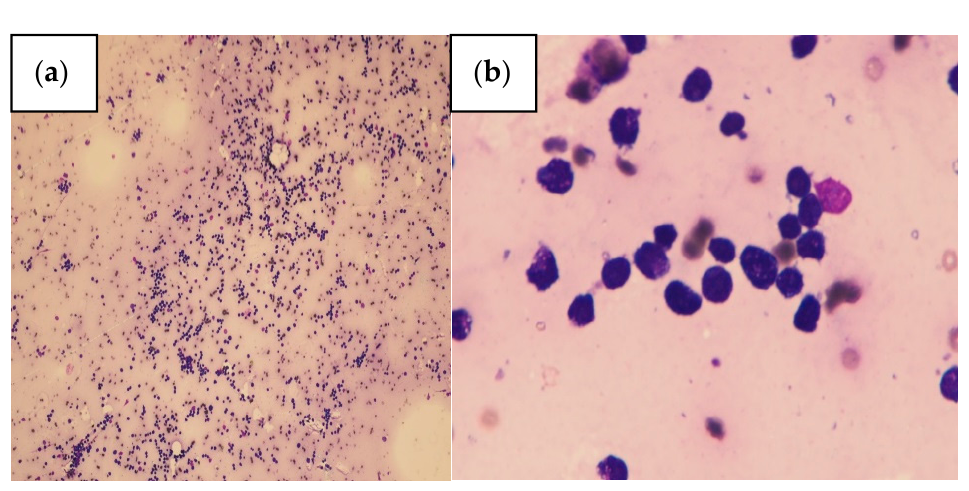
Figure 1. Bone marrow pathology. ( a ) Bone marrow cytology showed hypercellular marrow for age (90%), hypoplasia of myeloid, erythroid series and megakaryocytes; ( b ) Bone marrow cytology revealed bone marrow filled with lymphoblasts (86.1%).